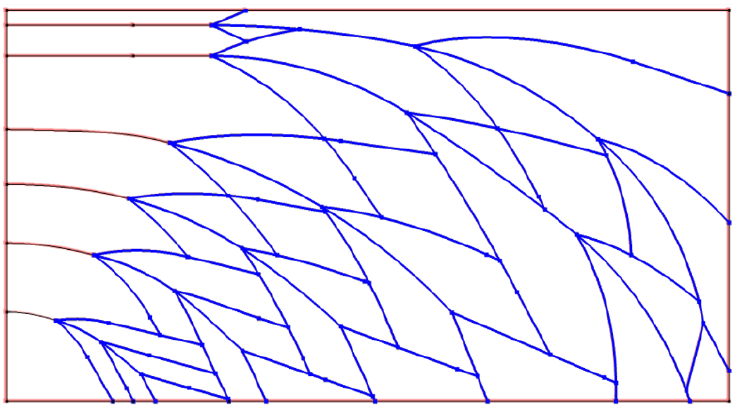
Figure 7. Design regions decomposition: region 1 (in red color) and region 2 (in blue color).